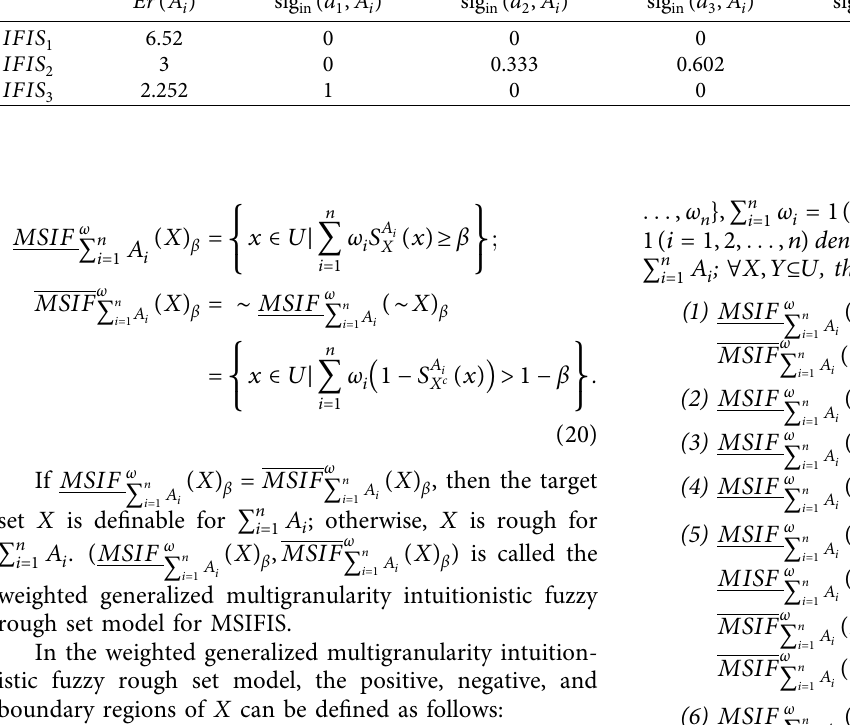
Table 3: The calculation results for each IFIS